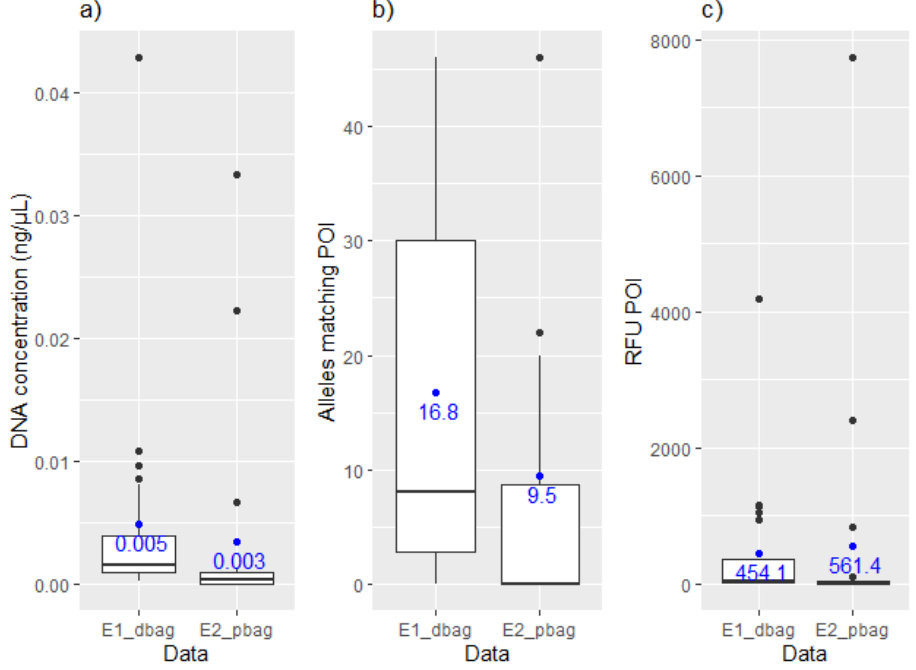
Figure 1. Boxplots displaying ( a ) the measured DNA concentrations (ng/ µ L in 200 µ L), ( b ) the number of detected allele’s matching the POI and ( c ) the RFU POI for the samples in the E 1 dbag (direct) and E 2 pbag (indirect) data.